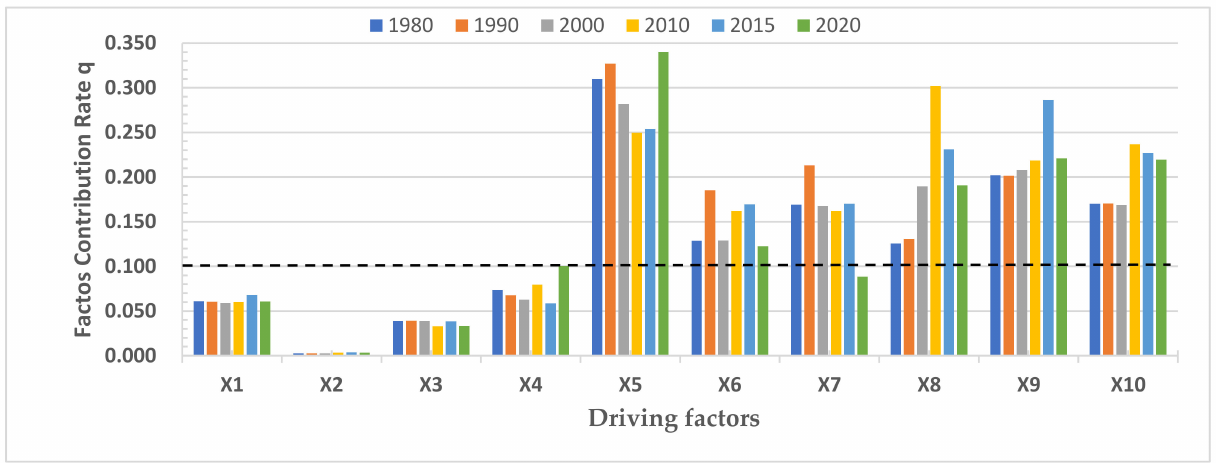
Figure 6. Contribution rates of driving factors for spatial differentiation of eco-environmental quality in Qinghai from 1980 to